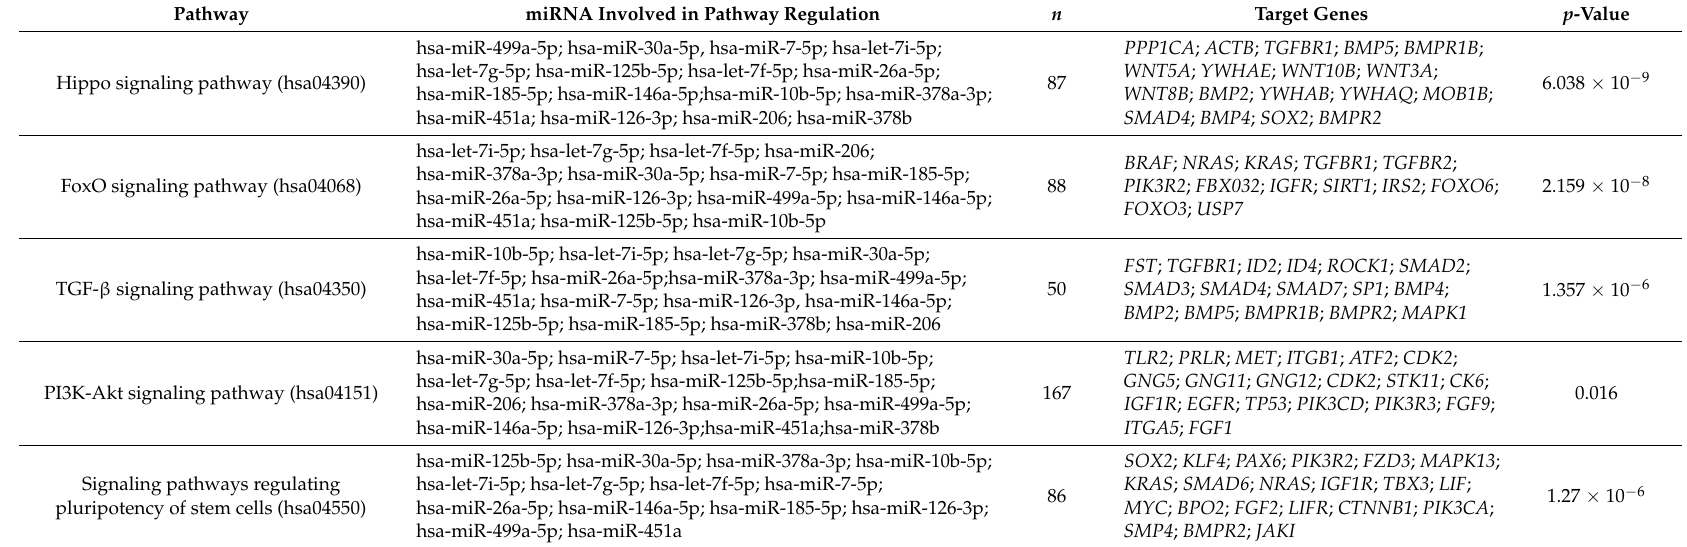
Table 3. The pathways and genes regulated by identified miRNAs ( N -number of genes regulated in each